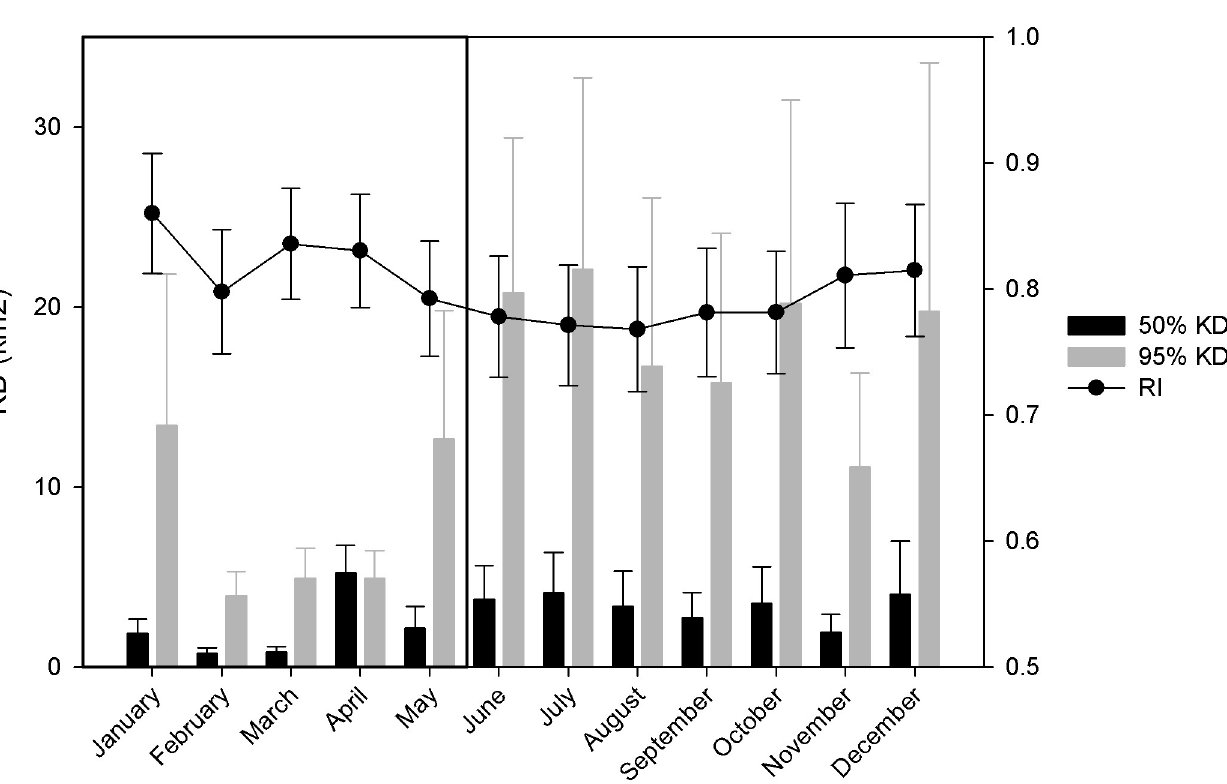
Fig 3. Monthly residency index and kernel density. (A) Monthly residency index (number of days detected divided by the number of days in each month) and (B) Monthly KD for transient, semi-transient, and resident female grey reef sharks tagged at Pohnpei and Ant Atoll, Micronesia during two tagging events in 2010 and 2012. The black box outlines aggregation months (January–May), while the shaded area represents months when either two or all three groupers are present (February–April).